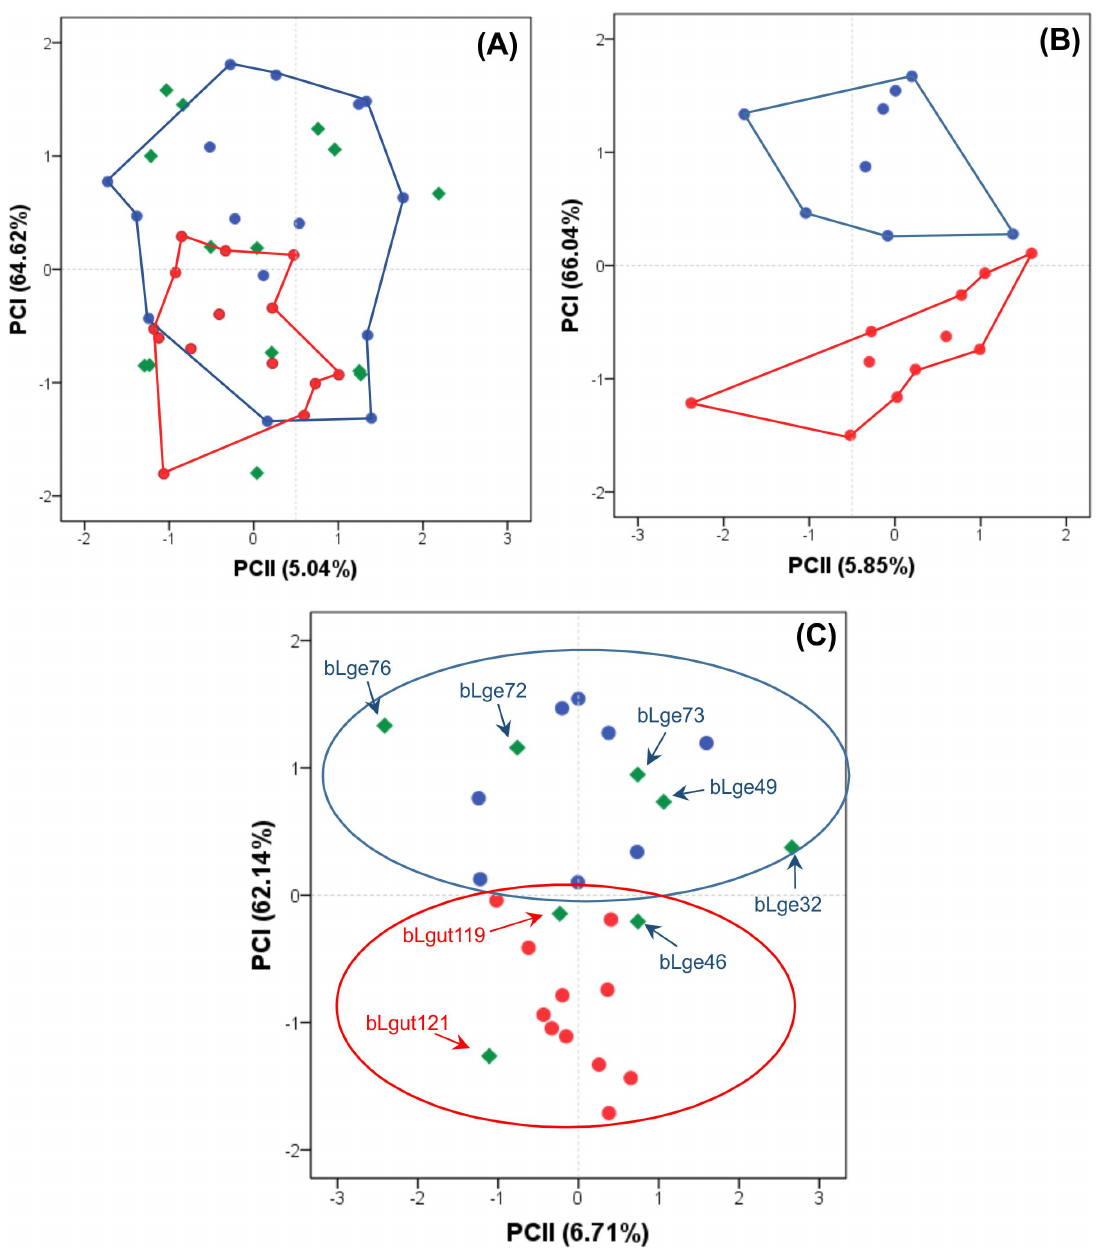
Figure 5. Results of the morphometric analyses. Principal Component Analysis (PCA) results are shown as graphs combining scores of the first (PCI) and second (PCII) principal components for: (A) all the assessed specimens, including information on whether each individual was identified genetically as pure L. guttulus (red circles), pure L. geoffroyi (blue circles) or a hybrid (green diamonds); (B) only male specimens identified genetically as pure L. guttulus (red circles) and pure L. geoffroyi (blue circles); and (C) same sample set as in (B), with the addition of genetically identified hybrids. Red and blue polygons (or ellipses) demarcate the morphological space encompassed by pure L. guttulus and L. geoffroyi individuals, respectively.